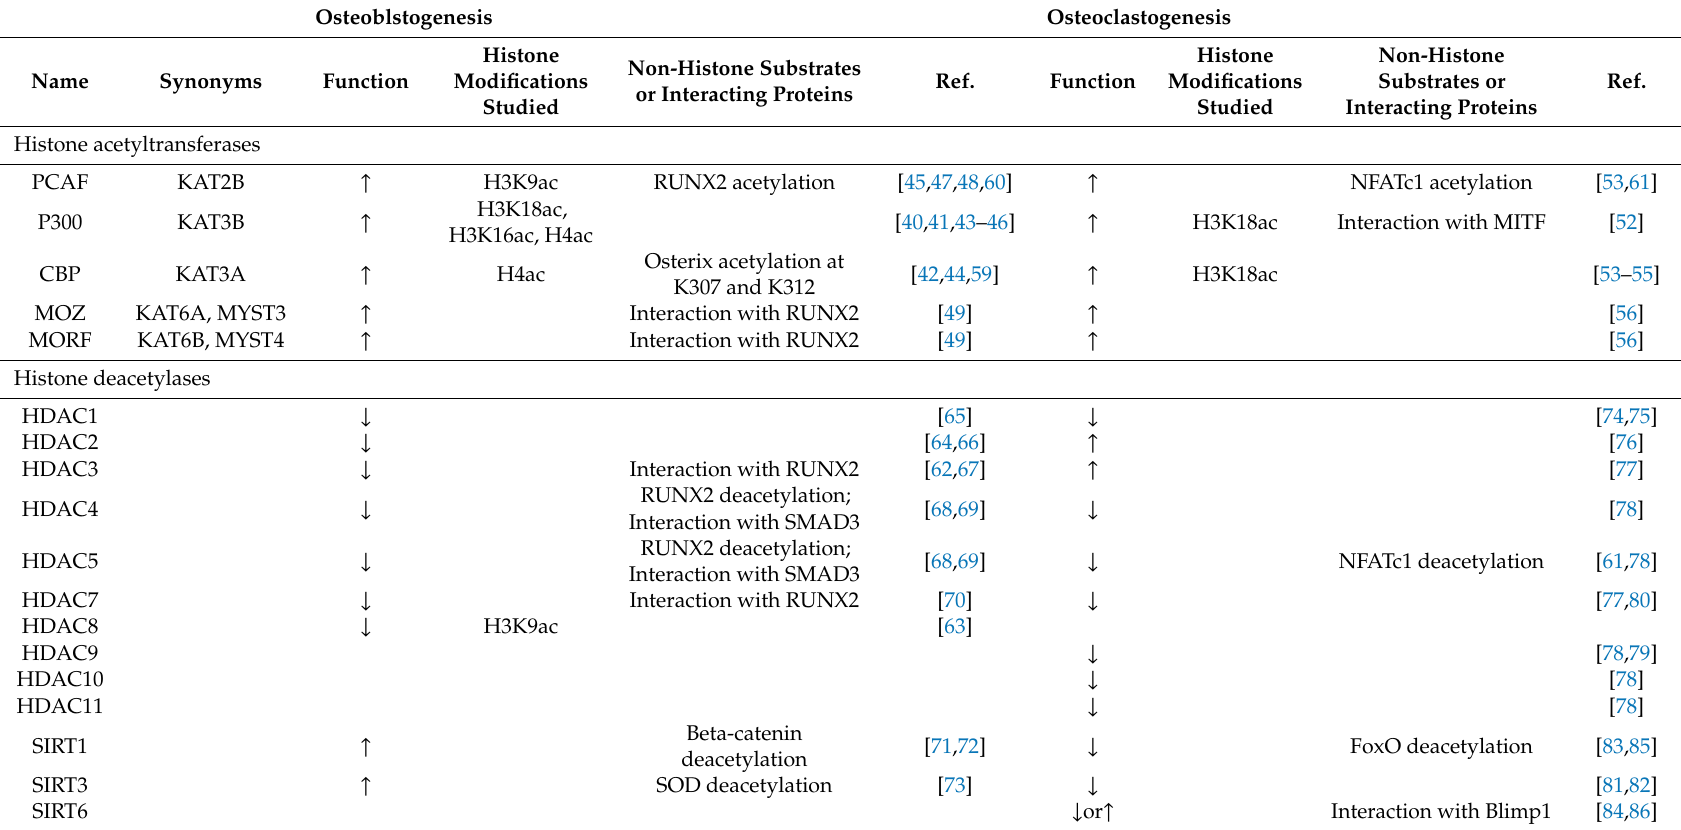
Table 1. Role of histone acetyltransferase and deacetylase on bone cell